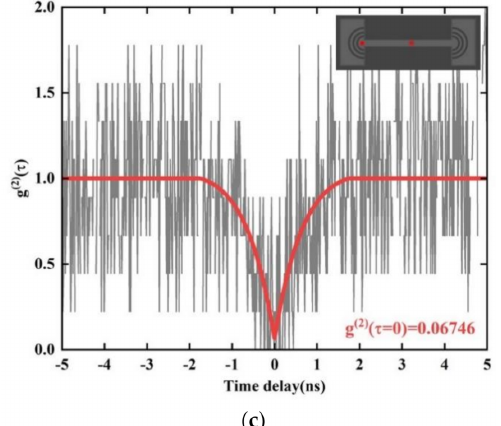
Figure 4. Second-order correlation measurements of the photons collected from ( a ) the quantum dot (QD) position, ( b ) the output coupler position, ( c ) the QD position, and the output coupler position, shown as red spots on the